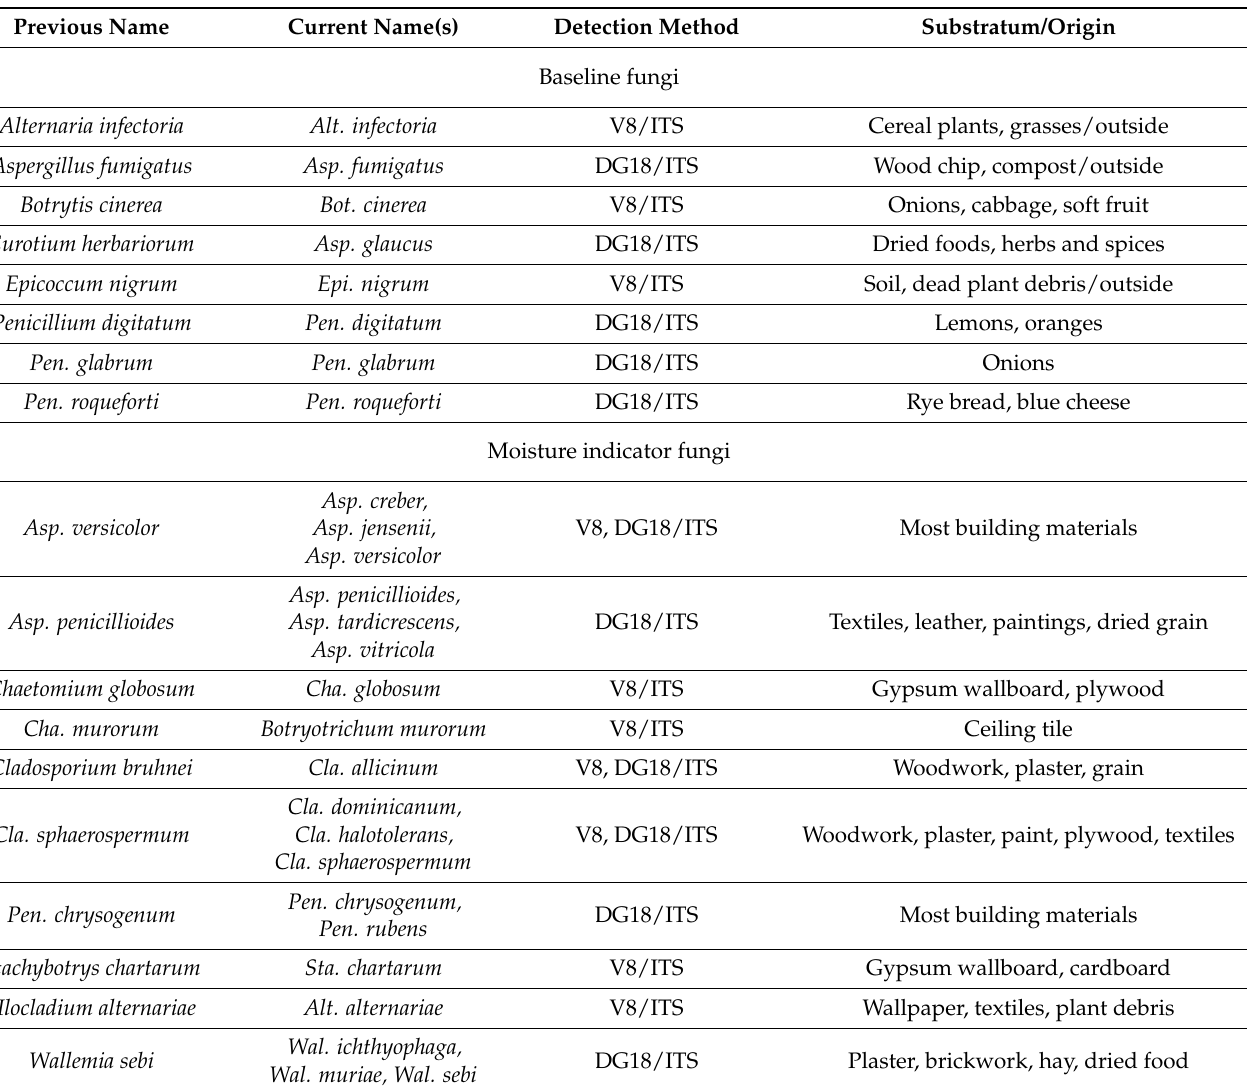
Table 6. Baseline fungi (spora) and moisture indicator fungi (mycobiota/funga) in a Danish setting. Current and previous species names, the detection method, and the most common origin are based on this study and studies by Andersen et al. [1] and Samson et al.